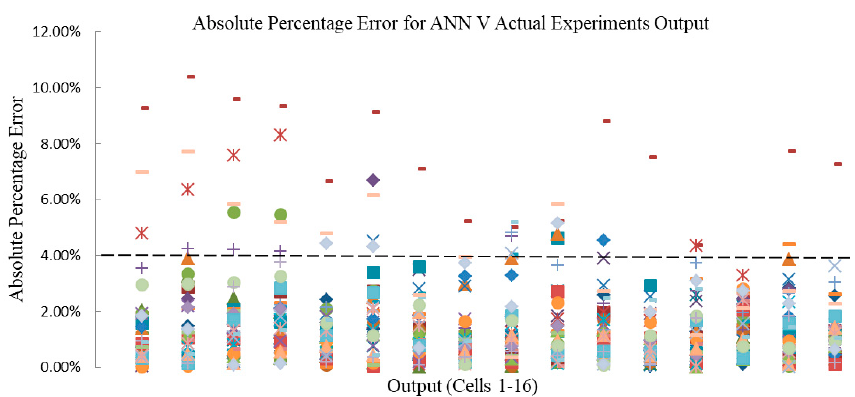
Figure 24. Percentage error between real output and predicted output values for the entire experiments.